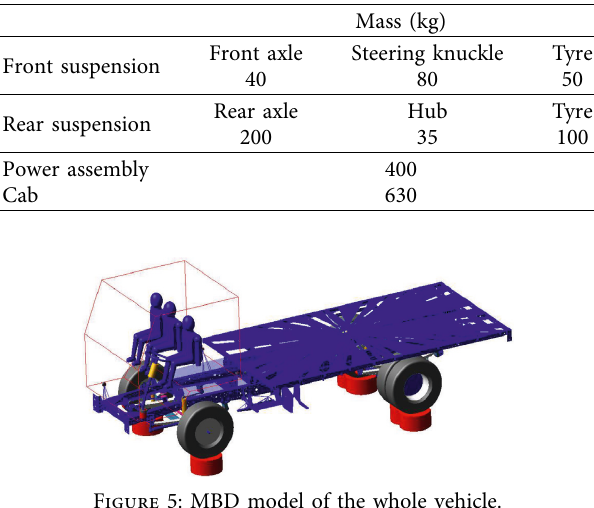
Table 1: Key mass parameters of the vehicle MBD model.